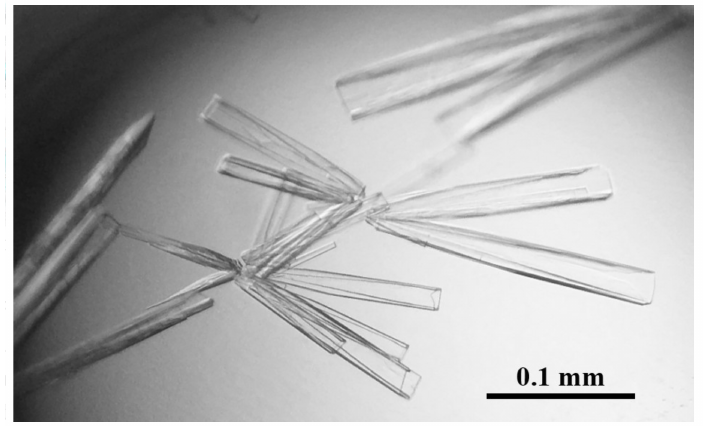
Figure 2. Crystals of